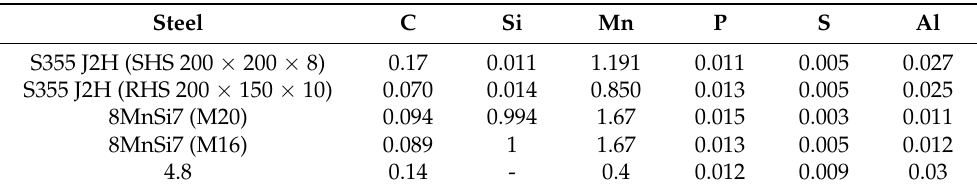
Table 3. Chemical composition of the tubes and studs. Composition in %. Steel